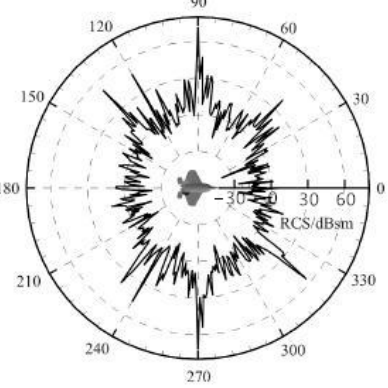
Figure 9. Radar cross-section distribution characteristics of an F-22 fighter jet.